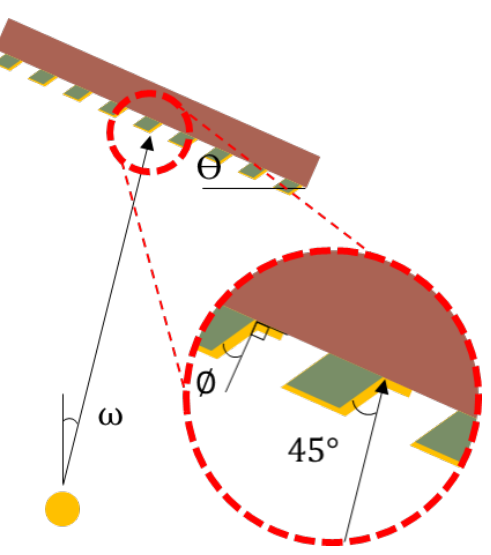
Figure 2. Scheme of the gold absorber deposition on the side wall.